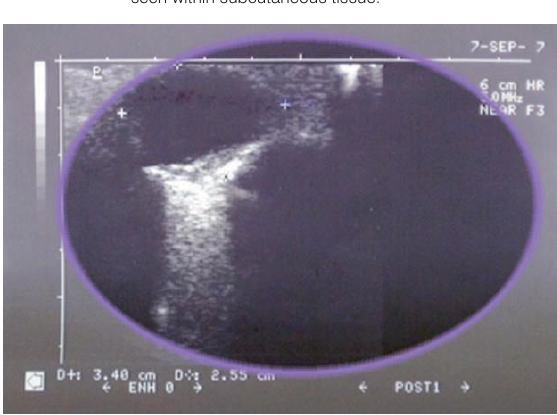
Figure 2. Ultrasonography of lower lip and cheek on the right side. Hypoechogenic solid lesion, 25 mm in diameter, can be seen within subcutaneous tissue.